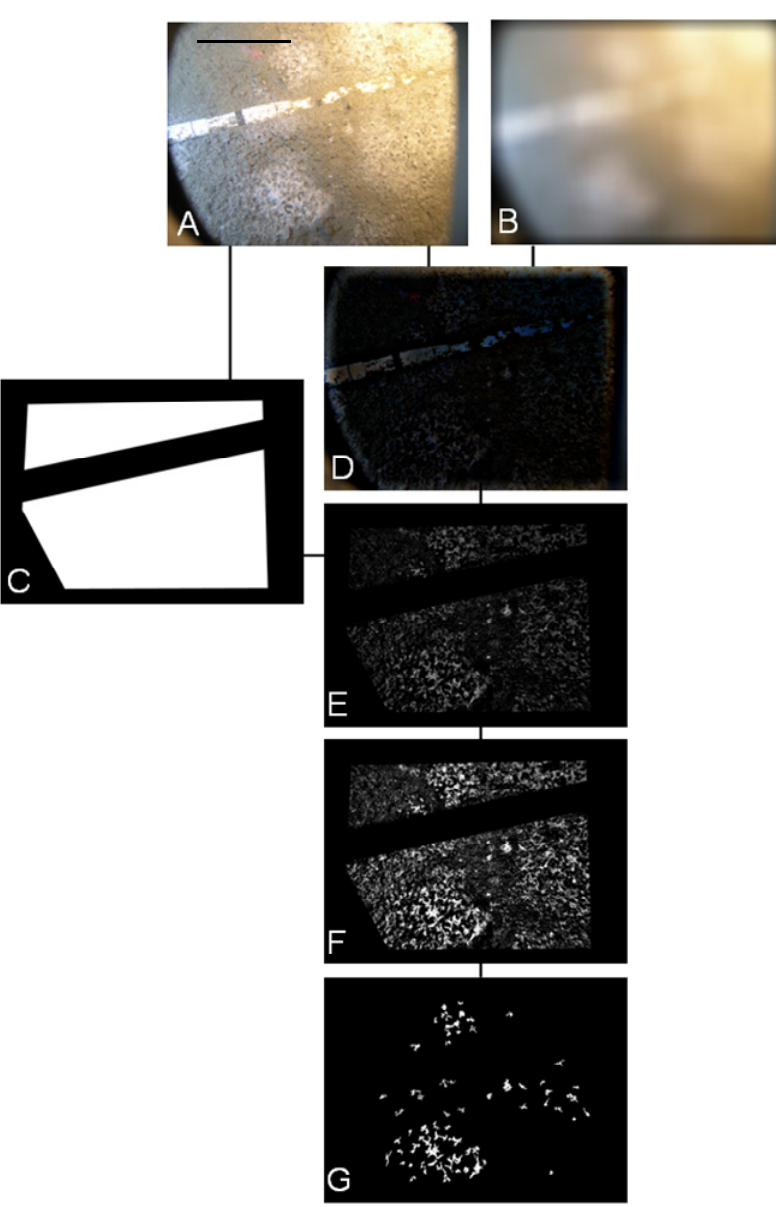
Figure 5. Example of the automated processing of an image with bacterial mats ( Beggiatoa spp.) as acquired by VENUS cabled observatory imaging system(scale bar: 10 cm): ( A ) Original image where the metric bar appears as semi-burrowed in the centre; ( B ) Background extraction with the Gaussian Blurring; ( C ) ROI definition (white areas); ( D ) Subtraction of the original image (in A) with its background (in B); ( E ) Sum of the RGB channels (ROI-selected); ( F ) Enhancement and rescaling; and finally, ( G ) Fixed thresholding (150) and small (<1,000 pixels) area eliminations. The Percentage of Coverage and the Fractal Dimension were calculated in the final digital product (in